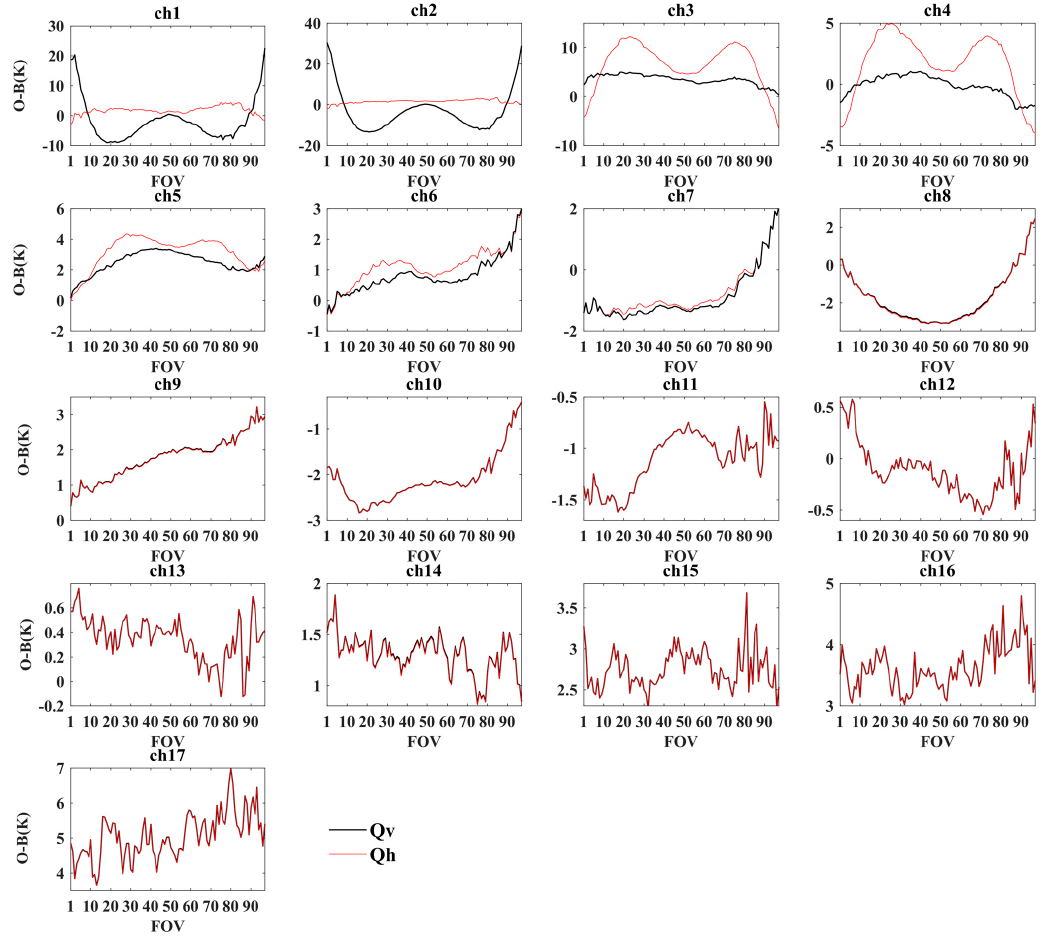
Figure 1. O − B scan angle dependence with 98 FOVs for FY-3E MWTS-III 17 channels. The simulations are computed by ARMS from 15 July 2021 to 15 August 2021.